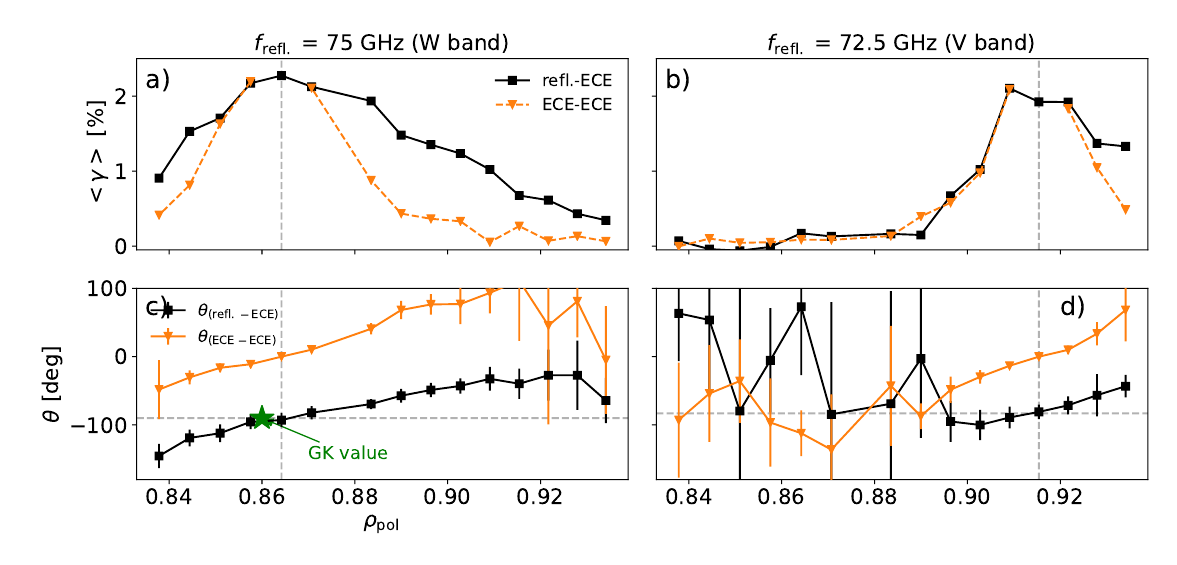
Figure 6. (a) and (b): Coherence between ECE channels (orange triangles) and ECE and reflectometer amplitude (black squares) averaged between 0-100 kHz for reflectometer probing frequency of 75 GHz and 72.5 GHz. The ECE coherence is scaled by 0.4. (c) and (d): The cross phases averaged between 10-40 kHz between the ECE channels (orange triangles), ECE and reflectometer amplitude (black